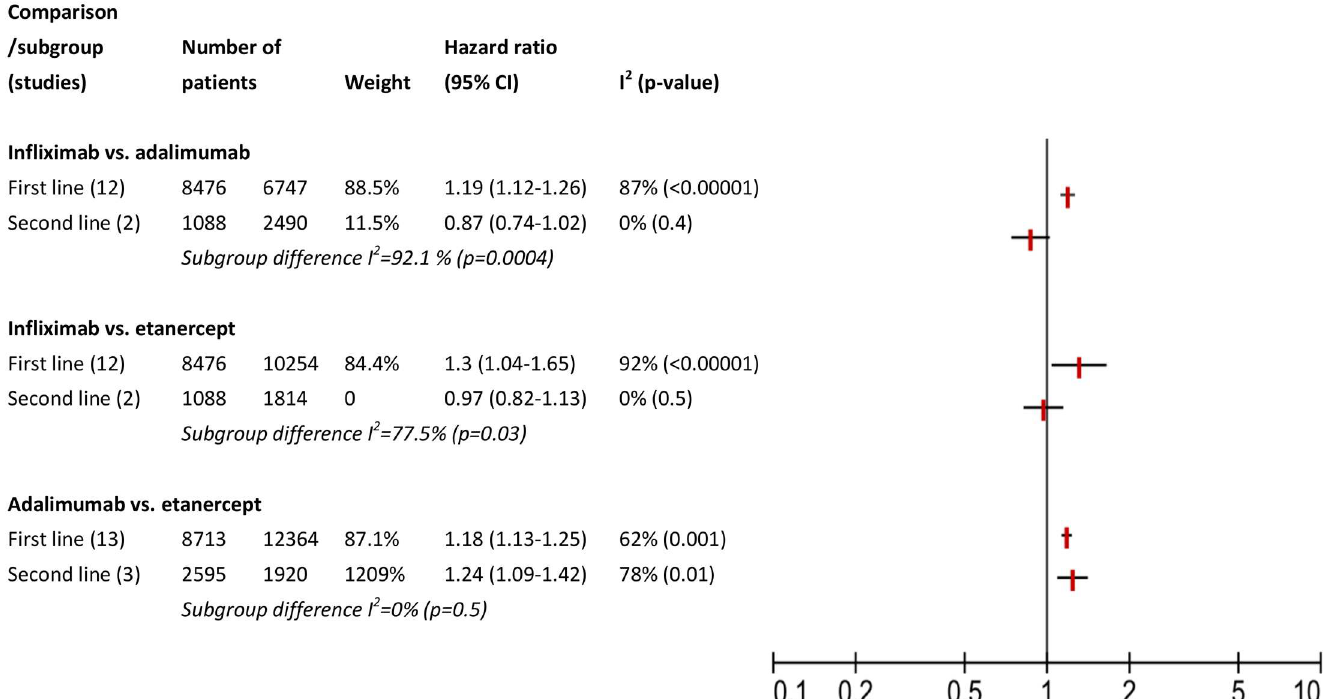
Fig 4. Assessment of clinical heterogeneity: subgroup analysis for order of